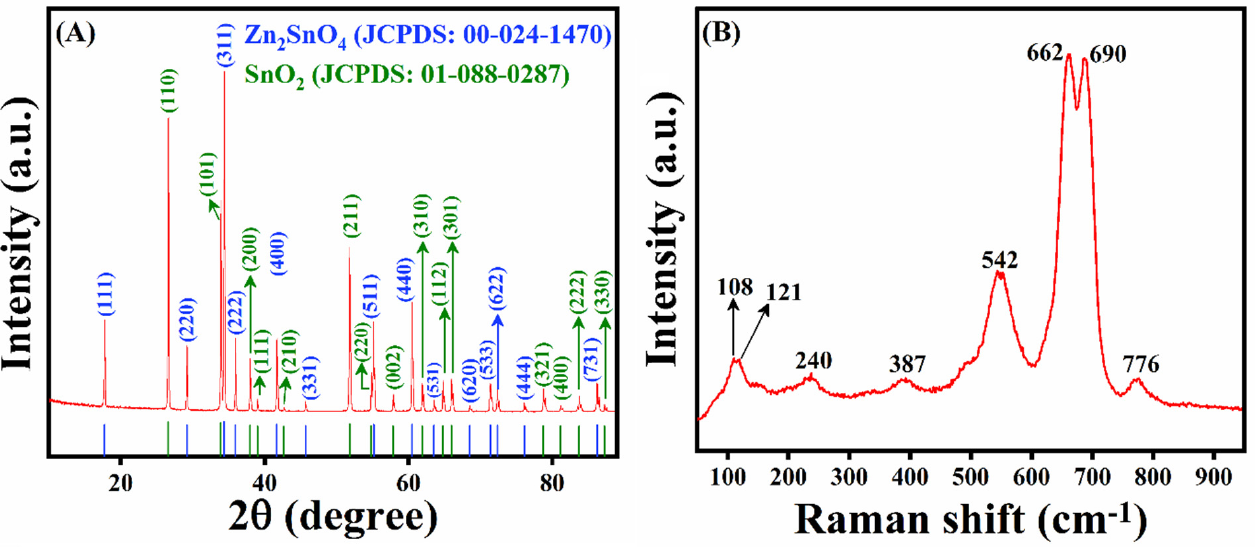
Figure 1. ( A ) XRD pattern and ( B ) Raman spectra of ZTO/TO MPs.